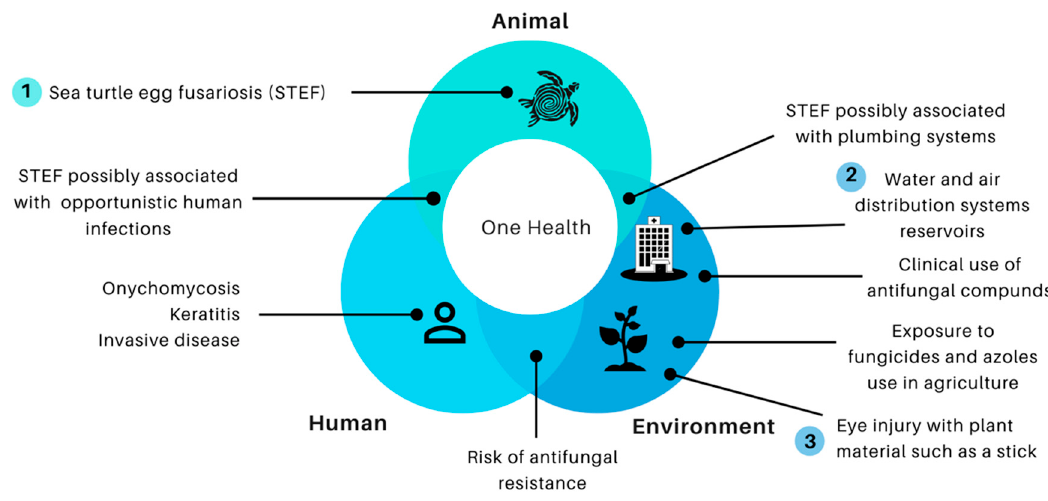
Figure 1. Animal, environment, and human interaction: a One Health